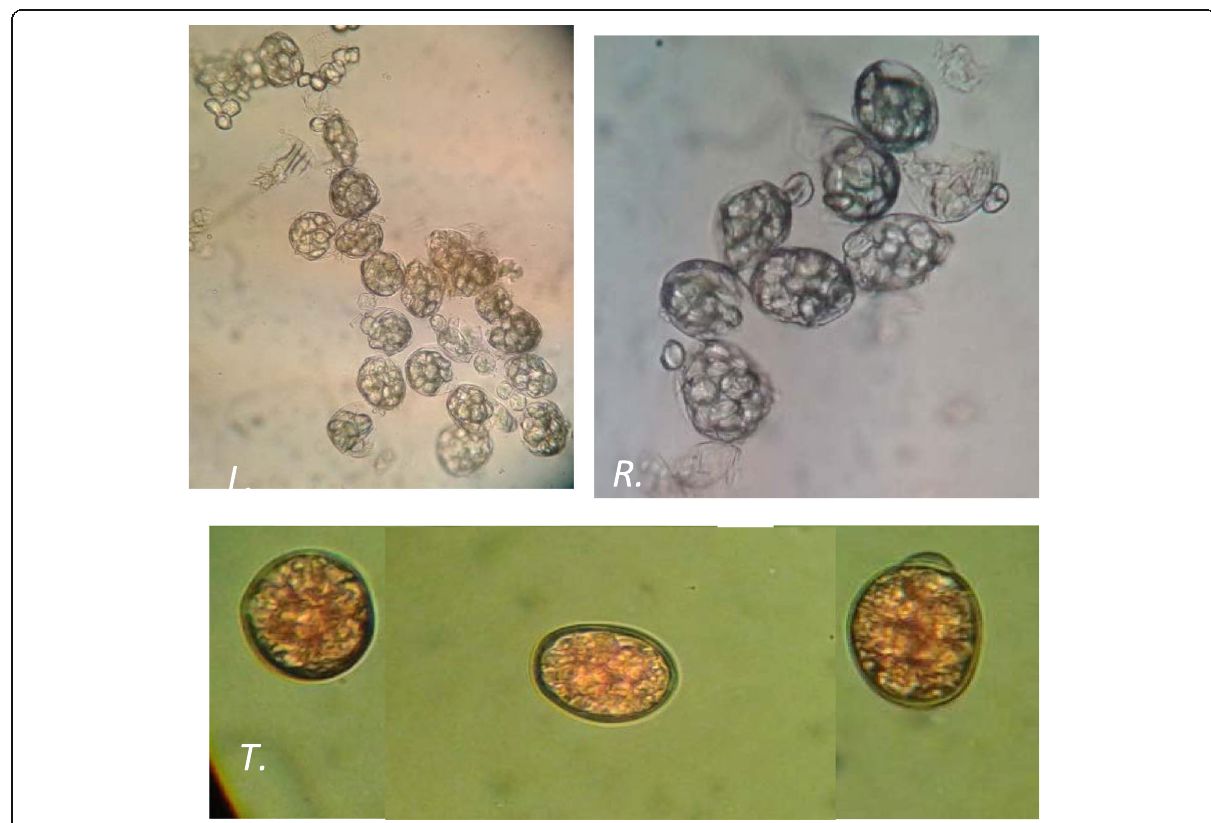
Fig. 4 Light microscope views of Adelina -polysporocystic oocysts isolated from Tribolium castaneum (T.) , Rhyzopertha dominica (R.) , and aemophloeus turcicus (L.) (×400 magnification)